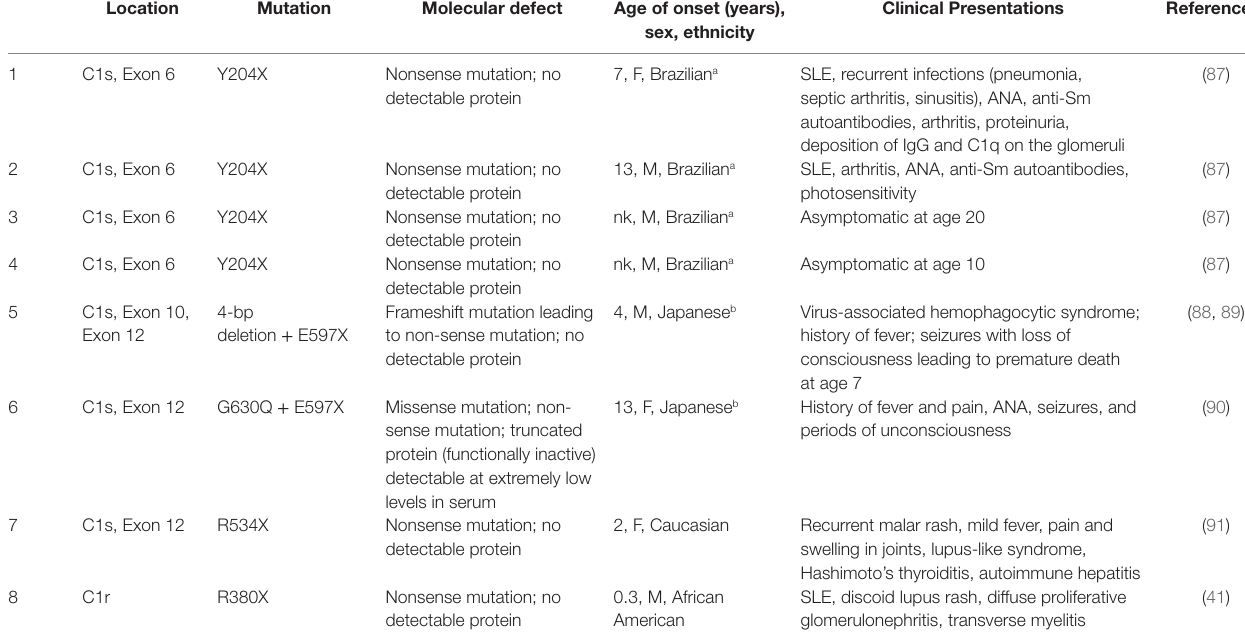
TABLe 2 | Molecular defects and clinical presentation of complete deficiency for C1s or